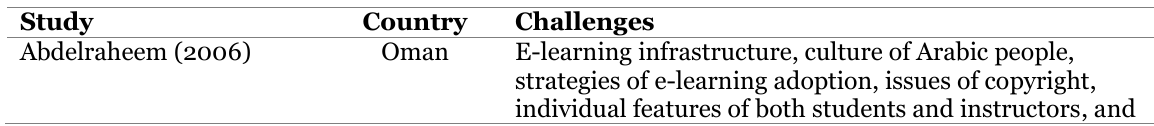
Challenges Hindering E-Learning Uptake in Middle East Countries